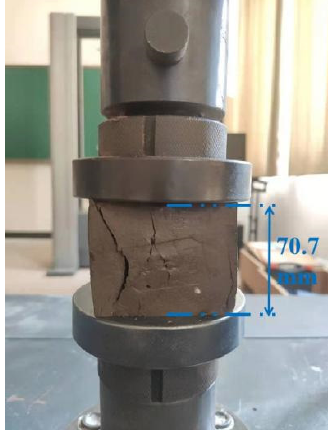
Figure 2. Unconfined compressive strength test.